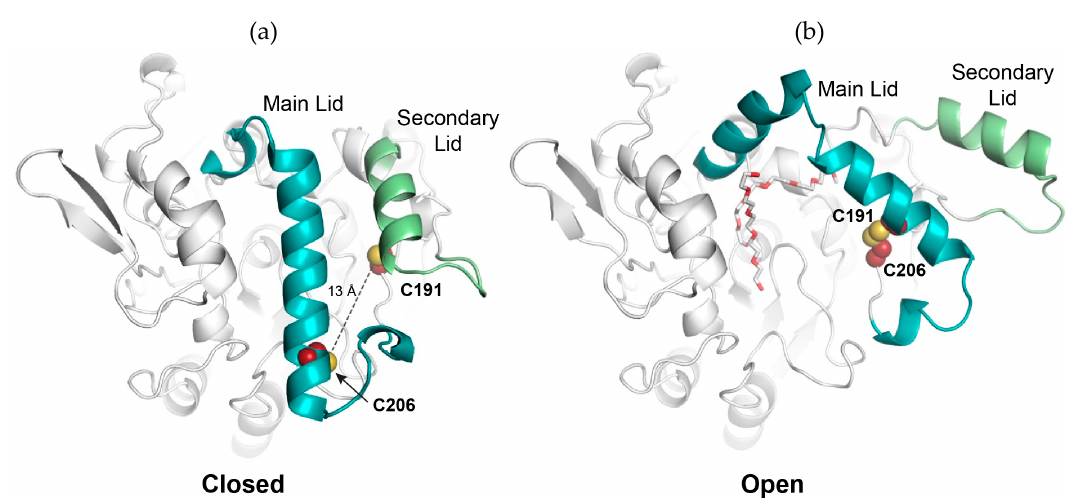
Figure 1. Design and modeled disulfide bond in co-crystallized wild type Geobacillus thermocatenulatus lipase 2 (cc BTL2). ( a ) Model of the closed conformation of cc BTL2 (using wild type Geobacillus stearothermophilus lipase 1 (BSL1) as template). The residues C206 and C191 (red and yellow spheres) are 13 Å away from each other (dotted line). The main and secondary lids are labeled (blue and green cartoons respectively). ( b ) Model of the open conformation of cc BTL2 based on the crystallographic structure of BTL2 in complex with Triton X-100 moieties (red and white sticks). In this conformation the cysteine residues are within an interaction distance to form a disulfide bond keeping ccBTL2 in an active conformation.